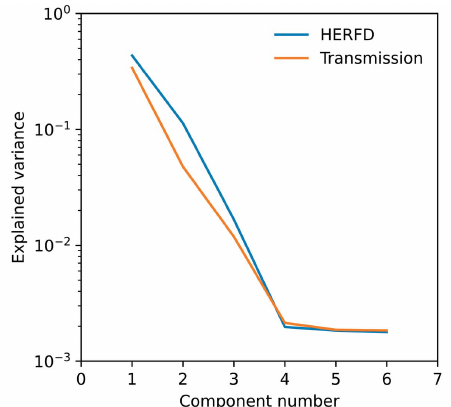
Figure 4 Scree plot for PCA components and the associated explained variance for both HERFD and transmission datasets of synthetically generated mixtures of various ratios of arsenopyrite, arsenolite, sodium arsenate, and scorodite. Note that, with HERFD, each of the first three PCA components can explain a greater amount of the variance in the